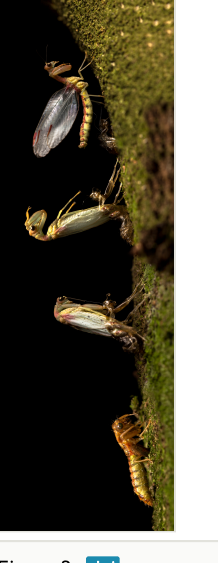
Figure 2. Eclosion of Ditaxis biseriata . The images, from bottom to top, show a pharate stage when it becomes stationary before eclosion begins (bottom), an adult in the process of extracting the wings and legs from the pupal case, an adult with its legs free of the pupal case and (top) an adult with its wings in the splayed condition progressively becoming transparent.